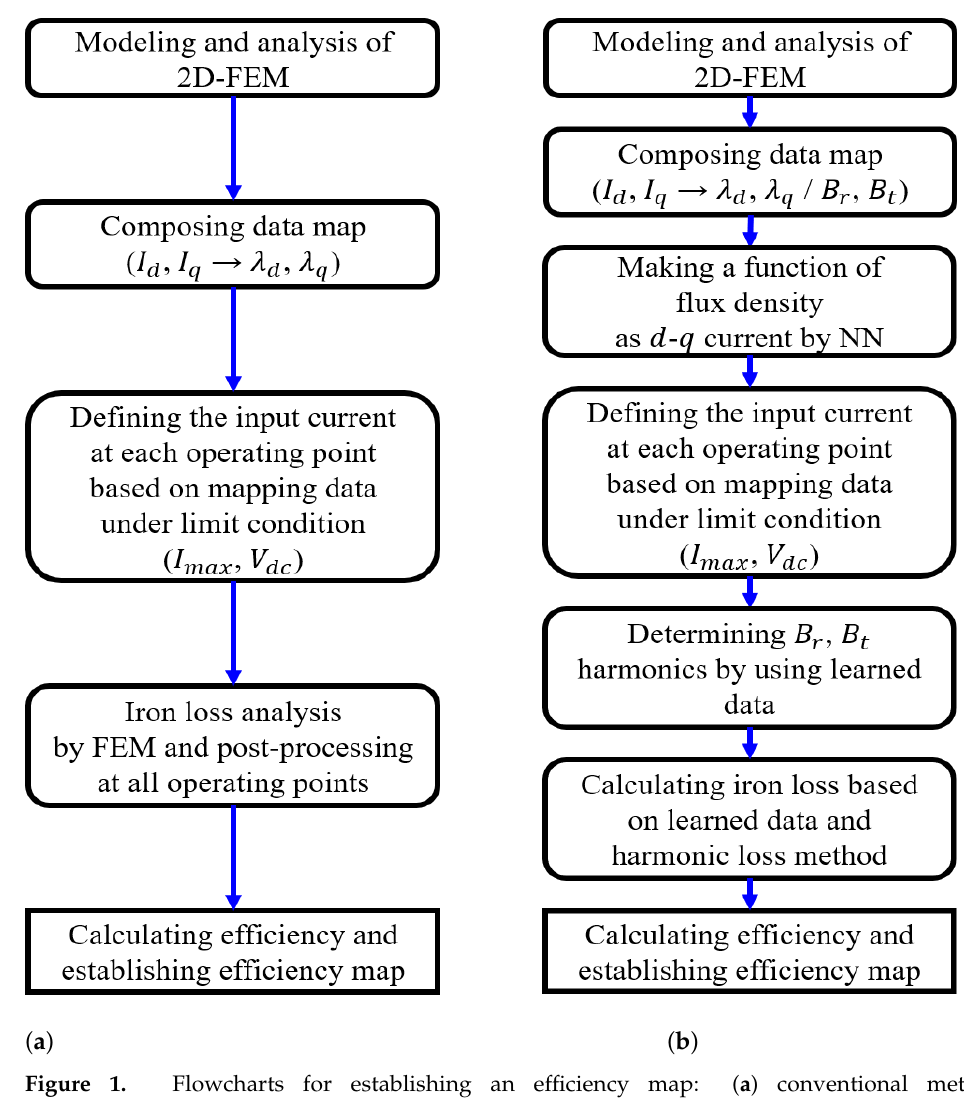
Figure 1. Flowcharts for establishing an efficiency map: